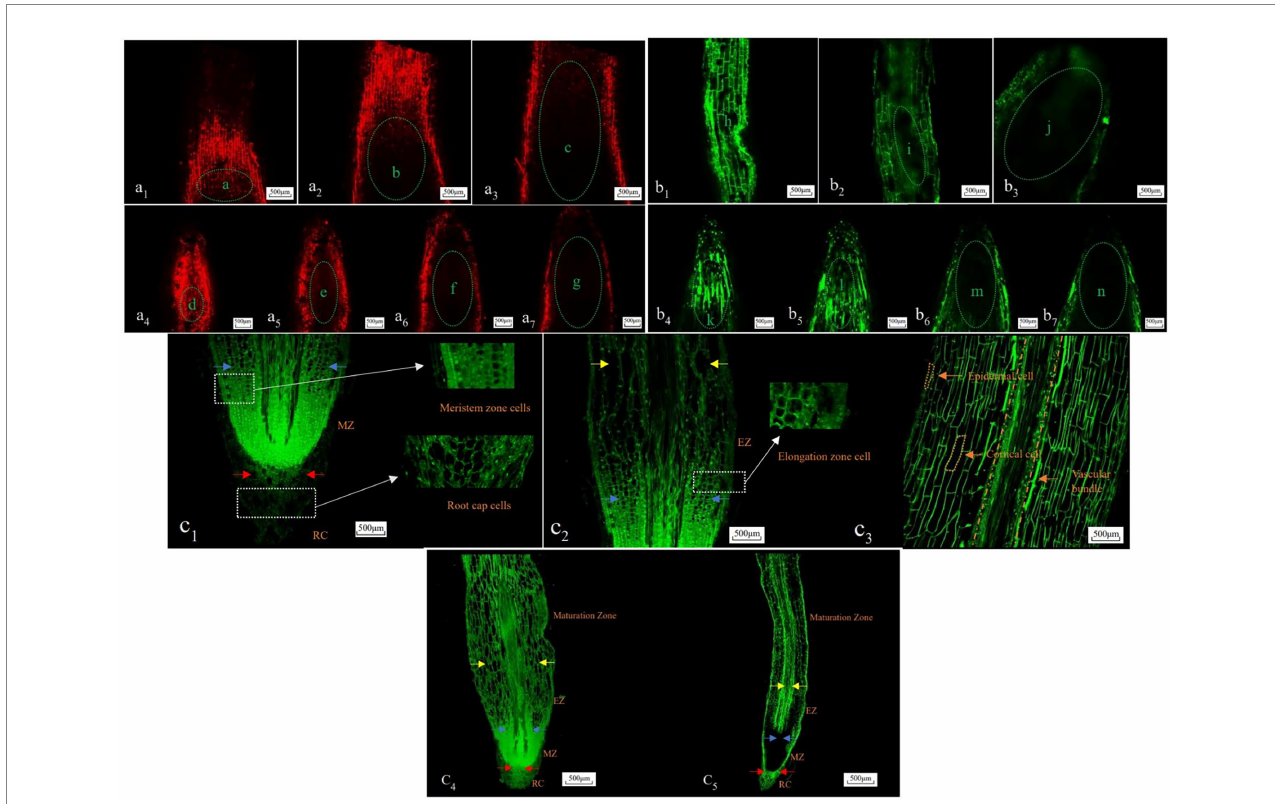
FIGURE 3 Longitudinal section cell morphology of Chinese fir roots under laser scanning confocal microscopy (LSCM) technique. a 1 –a 7 , b 1 –b 7 , c 1 –c 5 : Bar = 500 μ m. a 1 –a 3 and b 1 –b 3 : non-apical portion, a 4 –a 7 and b 4 –b 7 apical portion, a–n: middle root zone, c 1 –c 3 : longitudinal section anatomical structure of Chinese fir roots in microwave paraffin sections method, c 4 ,c 5 : Vertical and bending longitudinal section anatomical structure of Chinese fir roots in microwave paraffin sections method (×10). RC, root cap; MZ, meristem zone; EZ, elongation zone; c 3 and above the elongation zone is the maturation zone, the red arrow represents the upper boundary of the root cap, the blue arrow represents the upper boundary of the dividing zone, and the yellow arrow represents the upper boundary of the elongation